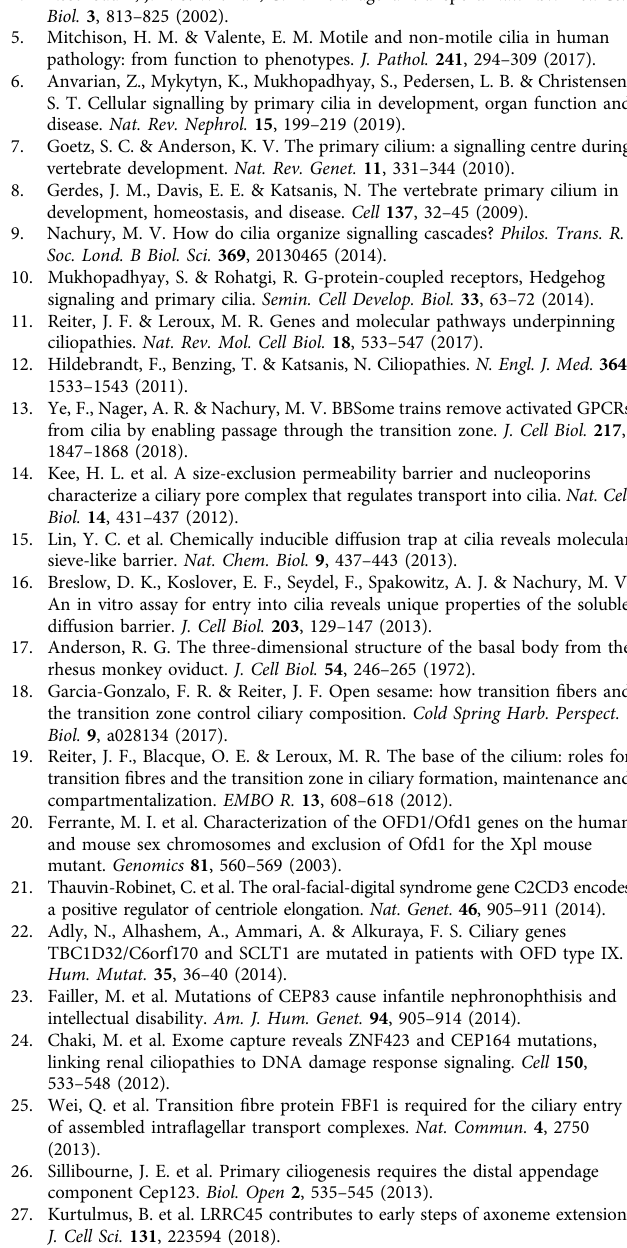
Fig. 7 TALPID3 and ANKRD26 orchestrate the cilia gating for membrane receptors. The localizations of PKD2 and Shh signaling pathway-associated proteins were analyzed in control, TALPID3 single-knockdown, ANKRD26 single-knockdown and TALPID3 and ANKRD26 double-knockdown RPE cells. Cells were examined by IF staining after 24 h of serum starvation with the indicated antibodies. a Compared with WT, TALPID3 single-knockdown, and ANKRD26 single-knockdown cells, TALPID3 and ANKRD26 double-knockdown cells showed signi fi cantly reduced ciliary entry of PKD2. Right panel, both the percentages of cells with PKD2 ciliary signaling and the mean fl uorescence intensity in each group were quanti fi ed. For PKD2-positive ratio, n = 300 cells over three independent experiments. For PKD2 intensity, numbers of cell examined are indicated above each dataset. b Cells treated without ( − SAG) or with ( + SAG) SAG were compared to analyze Gli3 and Smoothened (Smo) localization. c The percentages of cells with ciliary Gli3 and Smo were quanti fi ed. Results from a minimum of 100 cells in each group were averaged. The results from three independent experiments were statistically analyzed and plotted. n = 300 cells over three independent experiments. d A prospective model of the regulation of FBF1 by TALPID3 and ANKRD26. Recruitment of FBF1 to DAs/TFs or its stabilization on DAs/TFs requires coordination between the distal centriole wall and DA blades. Deletion of TALPID3 compromises the condition of the distal centriole wall, and deletion of ANKRD26 may affect the condition of the DA blade; therefore, co-depletion of TALPID3 and ANKRD26 exacerbates defects in FBF1 localization. All data are presented as the mean ± s.d. Signi fi cant differences were identi fi ed by two-tailed unpaired Student ’ s t test. NS, P > 0.05; ***, P < 0.001. No adjustments were made for multiple comparisons. Scale bars, 2 μ m. Source data are provided as a